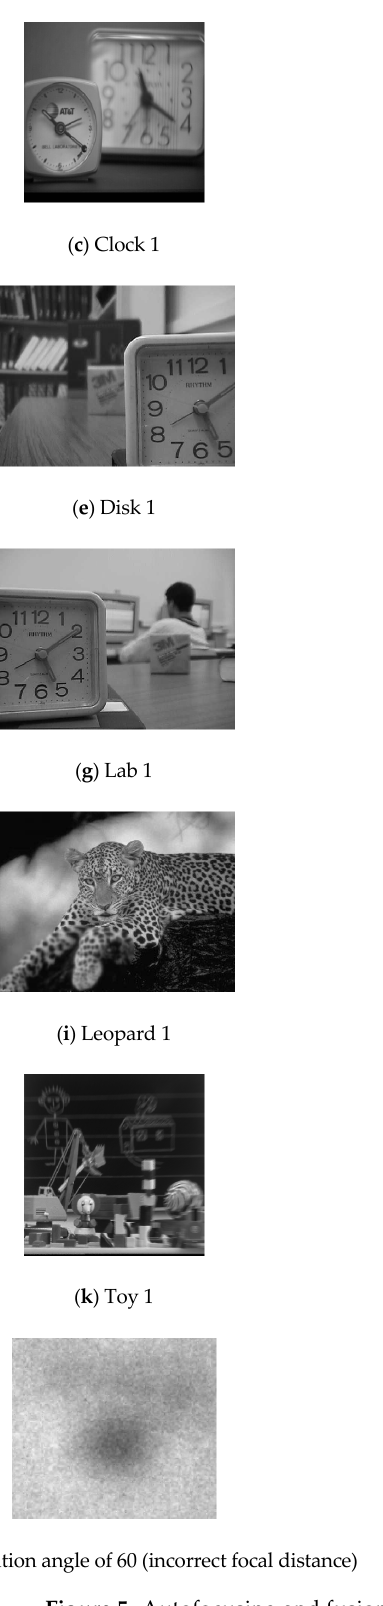
Figure 5. Autofocusing and fusion algorithm handling method.